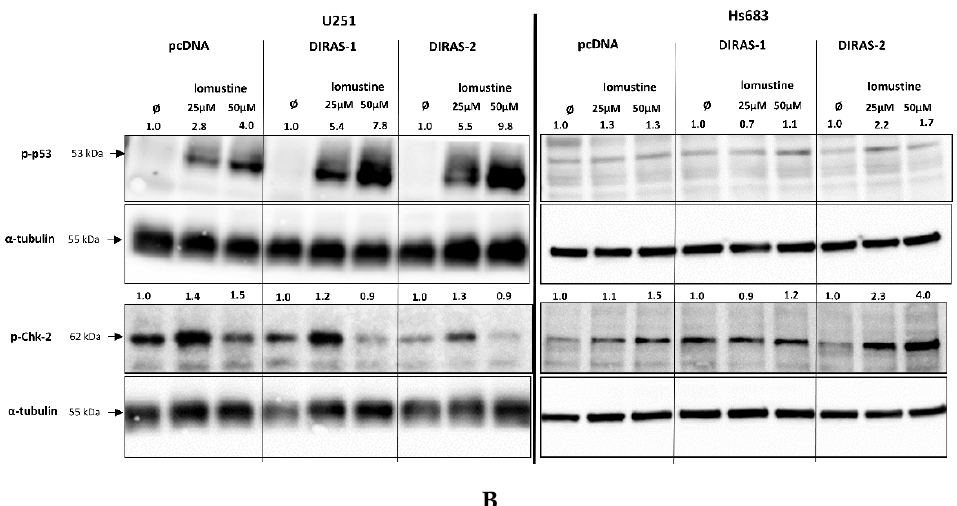
Figure 6. Western blot analyses of phosphorylation of DNA damage markers in DIRAS-1 or DIRAS-2 overexpressing glioblastoma cells after lomustin treatment. ( A ) Phospho-ATM (ataxia-telangiectasia-mutated gene), phospho-ATR (ataxia-telangiectasia and Rad3 related), phospho-BRCA-1 (breast cancer 1 gene), phospho-Chk-1 (checkpoint kinase 1), and phospho-H2A.X (H2A histone family member X), ( B ) phospho-p53 (transformation-related protein 53) and phospho-Chk-2 (checkpoint kinase 2). Original figure in Figure S. Detailed information about Western Blots can be found in the supplementary materials section.